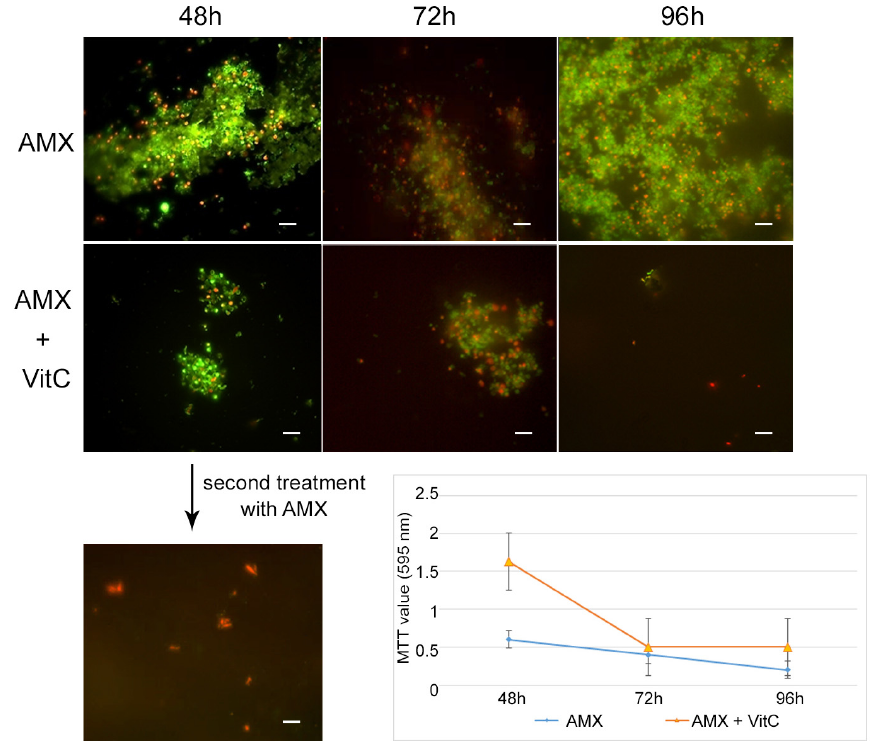
Figure 6. VitC effect on AP generation . Representative images of Live/Dead staining showing the effect of adding VitC to AMX on H. pylori cells during the AP generation. Monitoring occurred after 48 h, 72 h, and 96 h of incubation, and a comparison with the untreated sample was conducted (AMX). The second treatment with AMX guaranteed the complete killing of the population growing in AMX plus VitC for 48 h. Original magnification, 1000×. In the graphic, the MTT values show an increase in the viability of the H. pylori cells in AMX +VitC for 48 h, compared to those grown only in AMX (untreated sample).